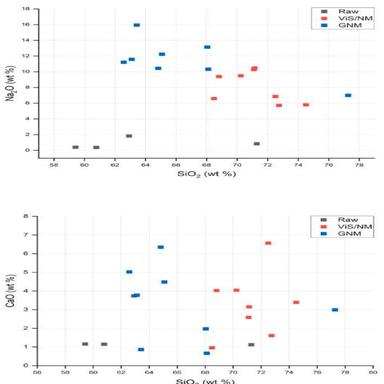
Bivariant plots Na2O versus SiO2; MgO versus SiO2 and CaO versus SiO2 of the raw/low fired, ViS-NM and GNM samples indicating a sodium enrichment towards the glass zone, a magnesium enrichment of the GNM and raw/low fired samples and a slight increase in calcium towards the glass zone (based on data presented in) . (For interpretation of the references to colour in this figure legend, the reader is referred to the Web version of this article.)